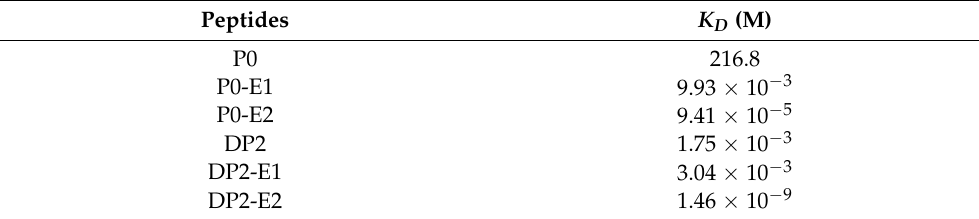
Table 2. Binding affinity of the native and DP2 based mutated peptides with